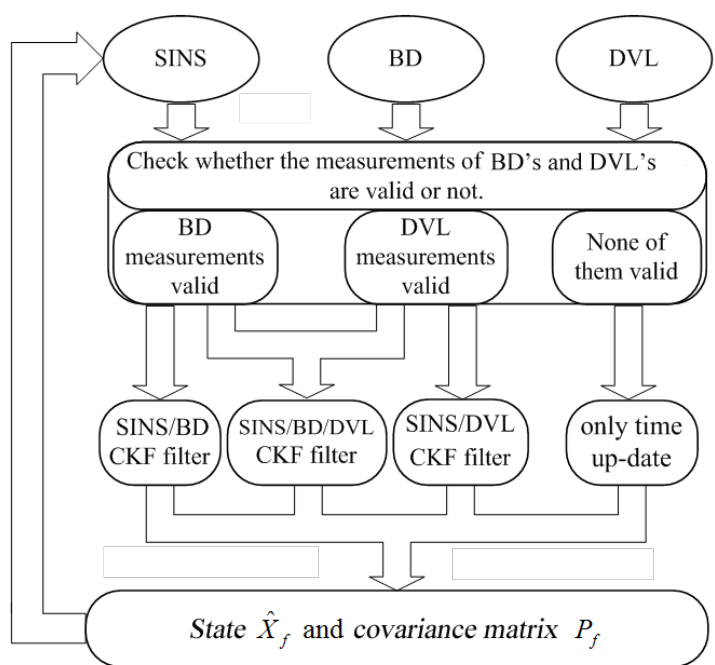
Figure 3. Flow chart of novel algorithm based on